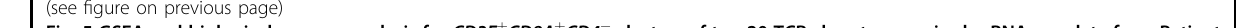
Fig. 5 GSEA and biological process analysis for CD3E + CD8A + CD4 − clusters of top 20 TCR clonotypes paired scRNA-seq data from Patient group vs . HD group. a Distribution of each group in CD8A + KLRB1 + CXCR4 + terminal differentiation T subset (left panel) and CD8A + CD160 hi effector T subset (right panel). b Using GSEA to analyze expressed genes from CD3E + CD8A + CD4 − clusters of top 20 TCR paired scRNA-seq data, 2 gene sets of interferon response signi fi cantly upregulated in Discharged group comparing with HD group ( n = 6 per group). NES, normalized ES; FDR, false discovery rate; NOM p, normalized p value. Top 20 BP enrichment analysis of DEGs from CD3E + CD8A + CD4 − clusters of top 20 TCR paired scRNA-seq data, which were upregulated in Discharged group vs . HD group analysis ( n = 6 per group) ( c ) and Follow-up vs . HD groups ( n = 7 in Follow-up group, n = 6 in HD group) ( d ). DC, Discharged group; FU, Follow-up group; HD, Healthy Donor